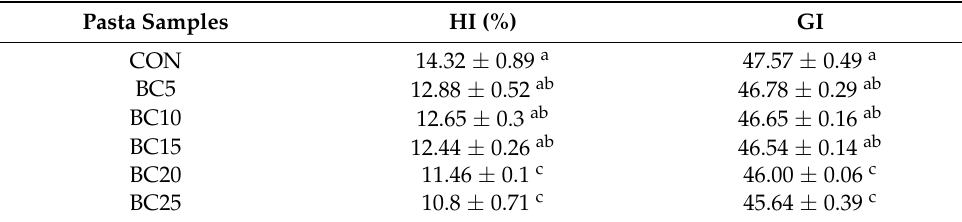
Table 6. Hydrolysis index of starch (HI) and glycemic index (GI) of the pasta samples. Pasta